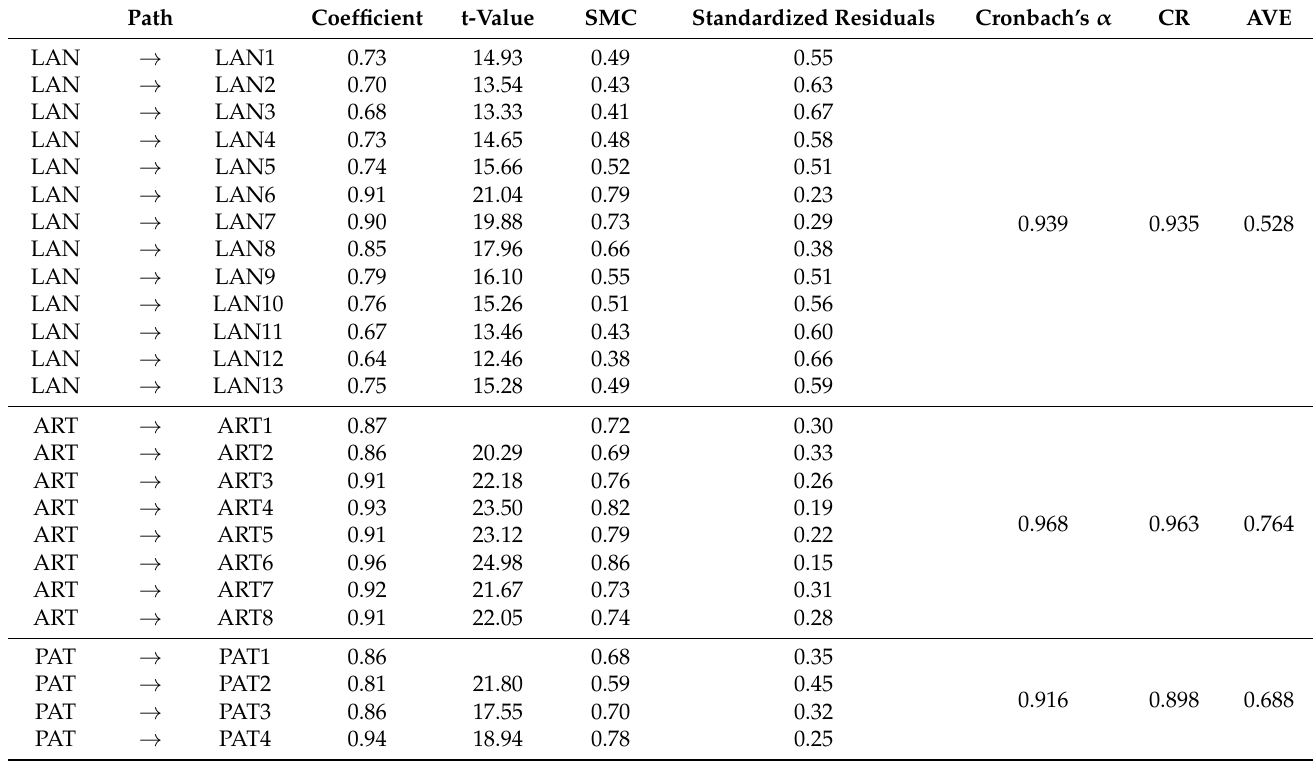
Table 3. Result of the confirmatory factor